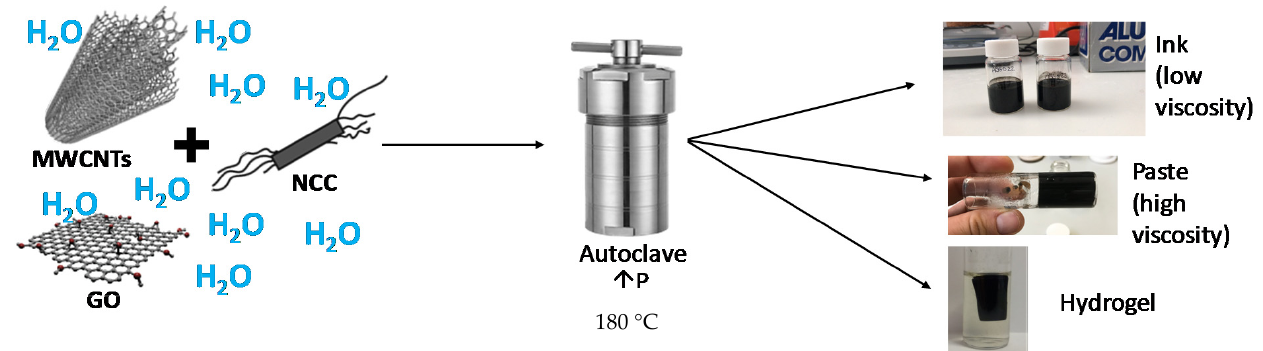
Figure 1. General scheme for the preparation of inks and pastes following the autoclave method.